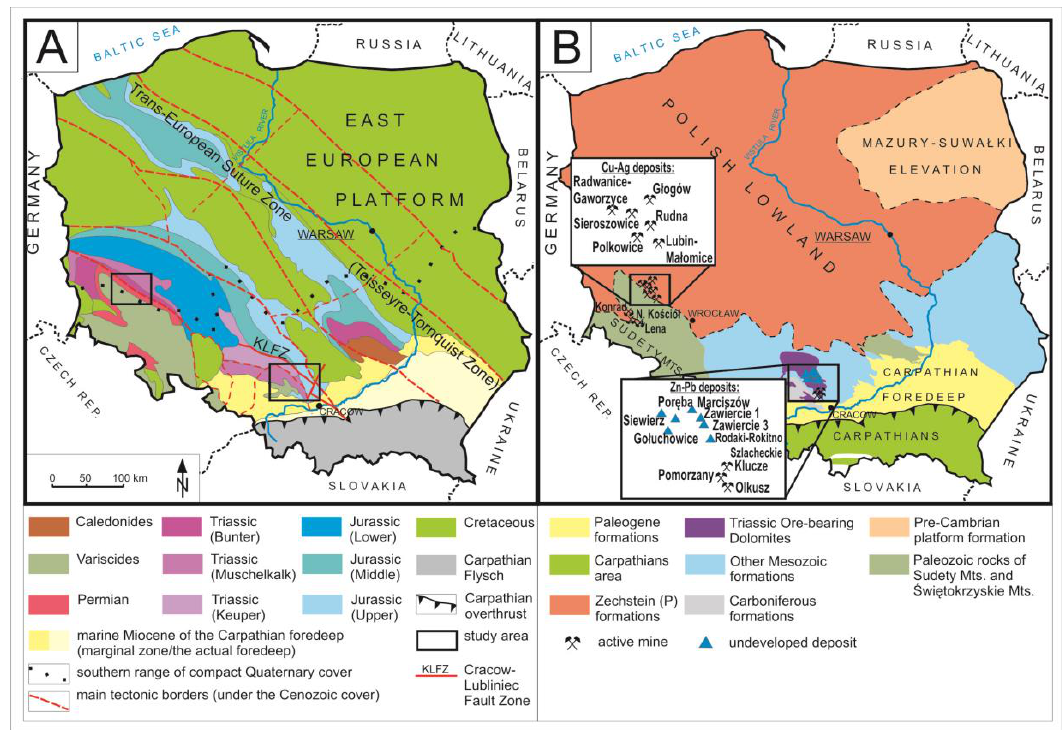
Figure 1. ( A ) A simplified geological map of Poland without Cenozoic cover (after [6]), with main tectonic borders under the Cenozoic cover and ( B ) the main metallogenic formations of Poland (after [18]) with location of investigated Zn-Pb and Cu-Ag deposits.